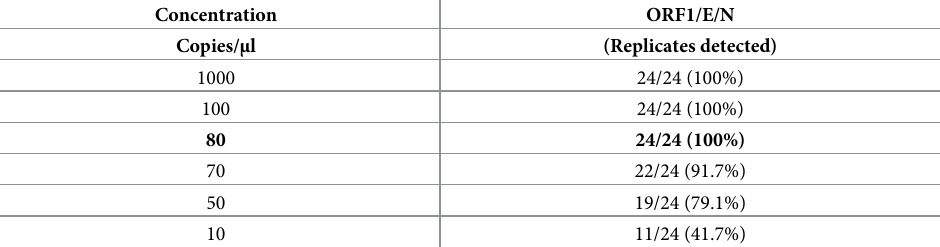
Table 6. Limit of detection (LoD) of the Prime CovidDetect ™ rapid detection